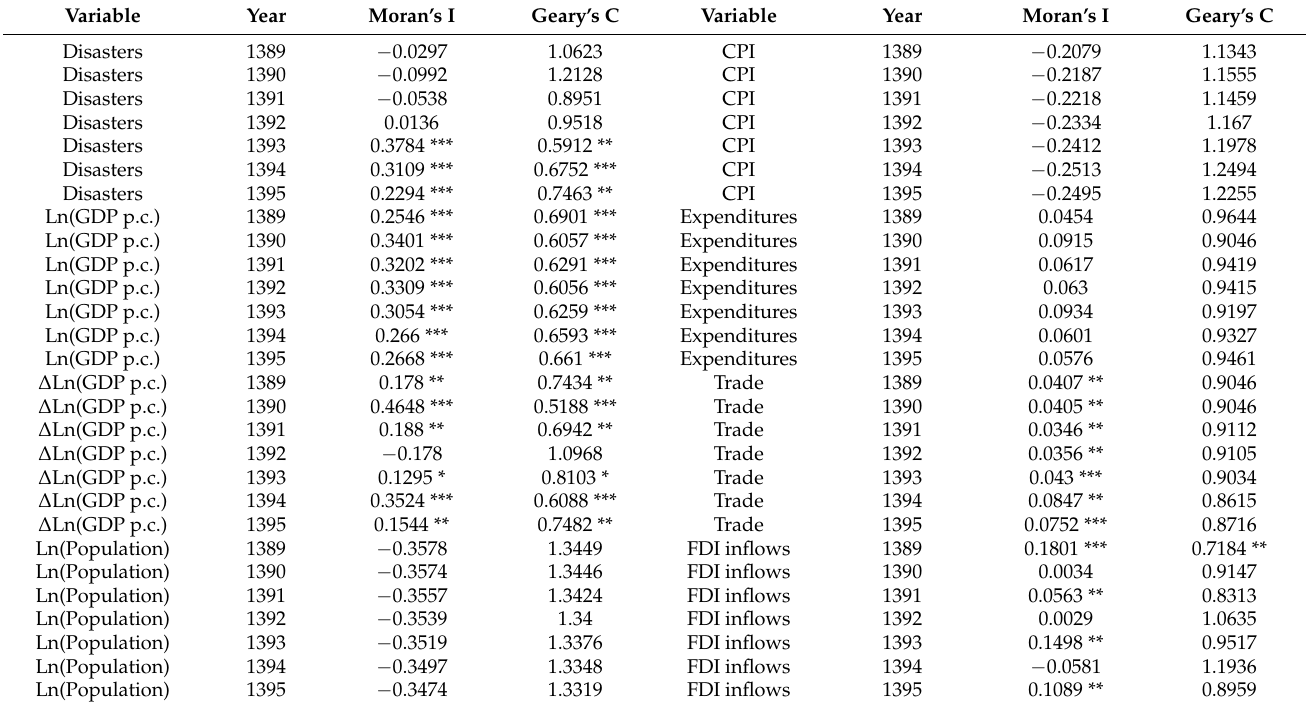
Table A4. Moran’s I and Geary’s C of used